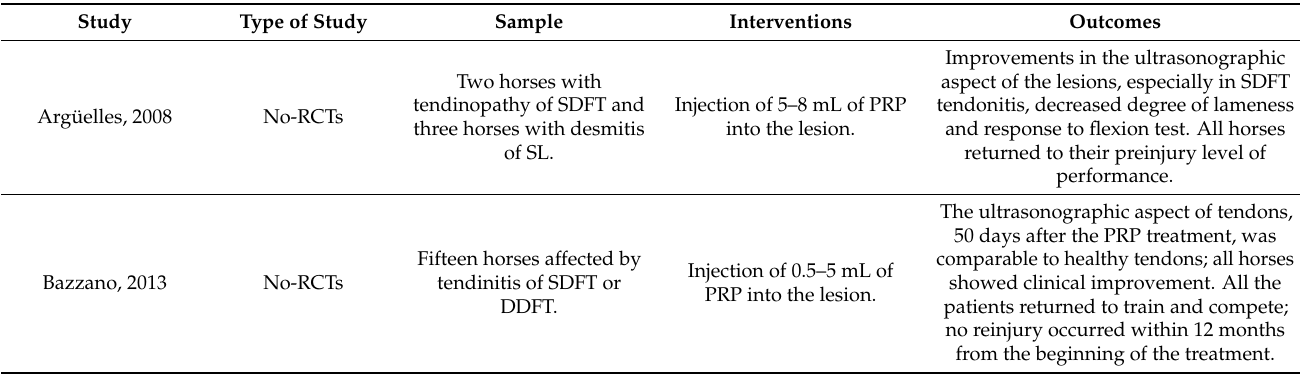
Table 3. Type of study, sample constitution, interventions applied, and outcomes considered in the studies involved in the systematic review. In bold: studies included in the meta-analysis. Study